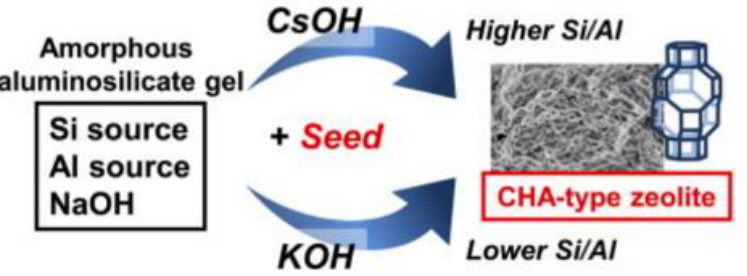
Figure 2. Schematic diagram of the CHA zeolite by a seed-assisted method in the absence of organic structure-directing agents. Reprinted with permission from ref. [40]. Copyright 2014, Elsevier.